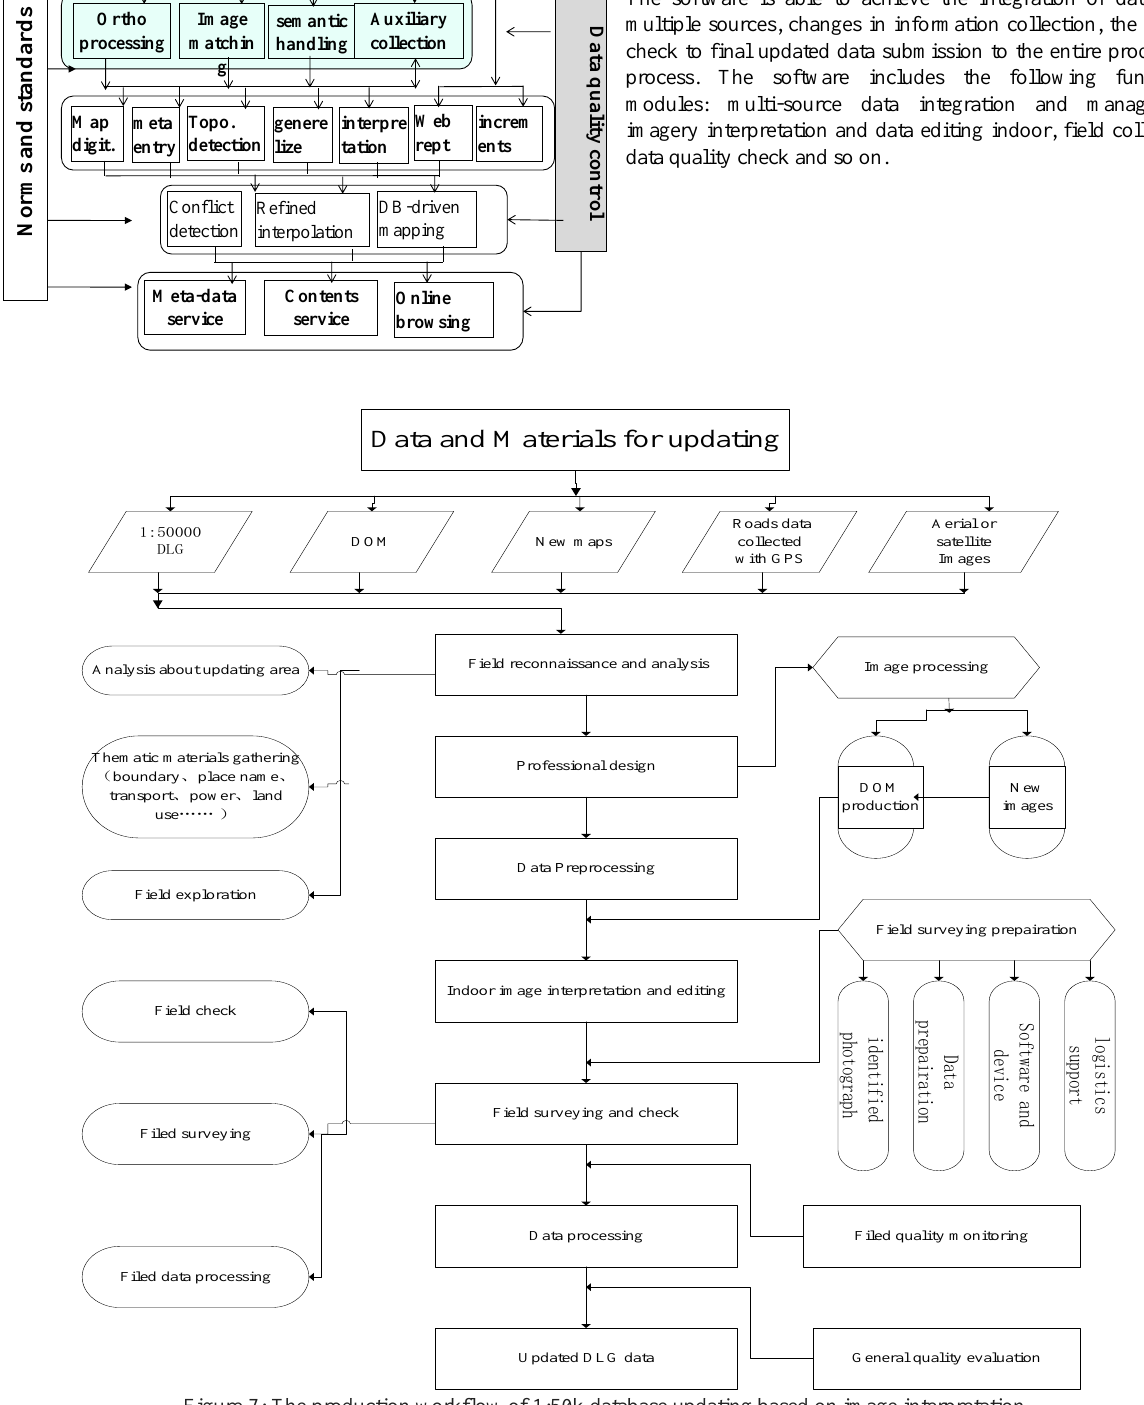
Figure 7: The production workflow of 1:50k database updating based on image